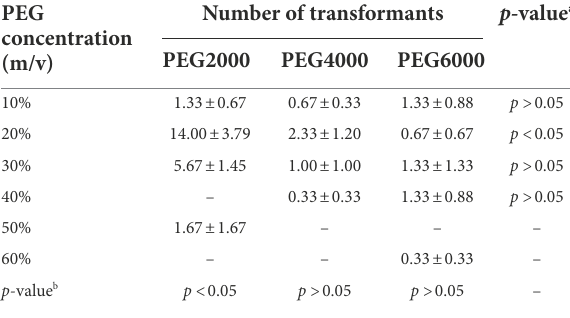
TABLE 1 Effects of different molecular weights and concentrations of polyethylene glycol (PEG) on the number of transformants (mean ±